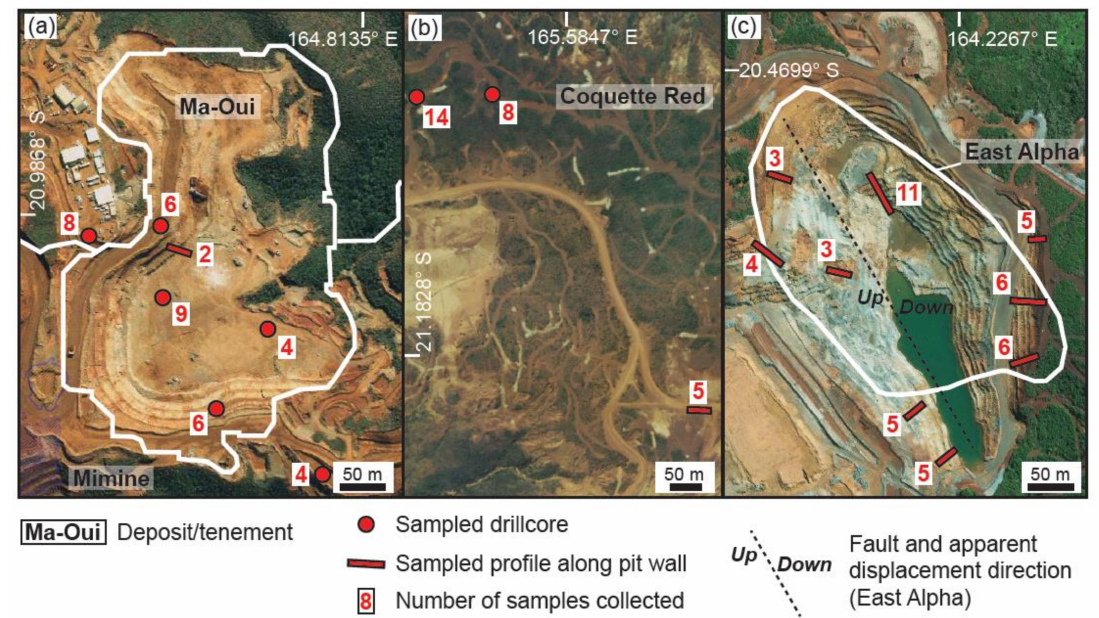
Figure 2. Outline of the investigated deposits and location of collected samples. ( a ) Ma-Oui de- posit (Koniambo massif). ( b ) Coquette Red tenement (Cap Bocage massif). ( c ) East Alpha deposit (Ti é baghi